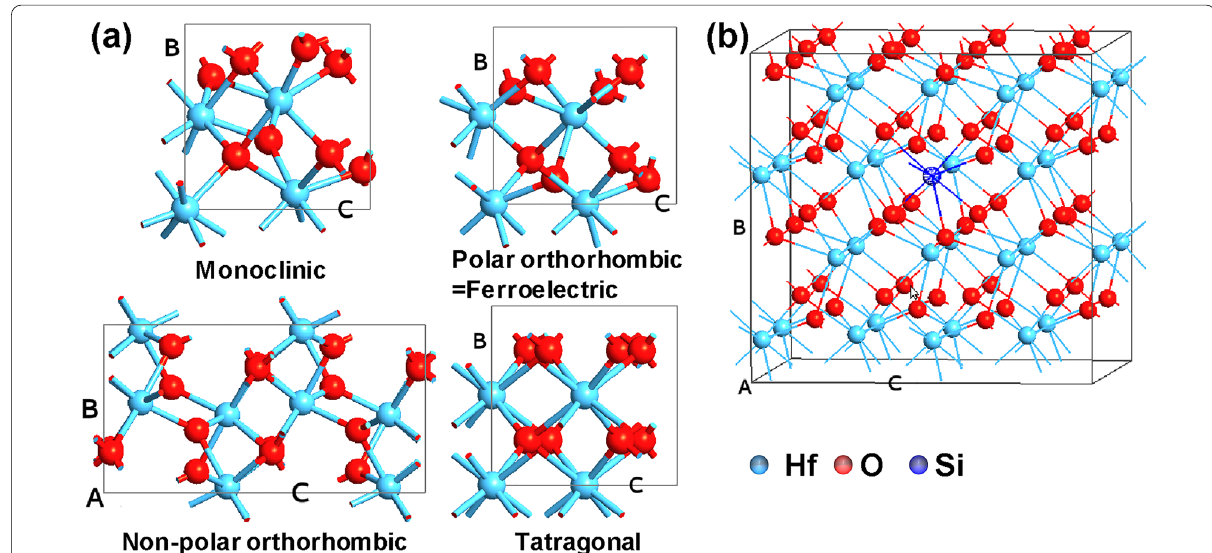
Fig. 1 ( a ) Unit cell structures of the monoclinic (m), polar orthorhombic (ferroelectric, f), non-polar orthorhombic (o), and tetragonal (t) phases, ( b ) Supercell structure with dopants, which is expanded by 2 orthorhombic